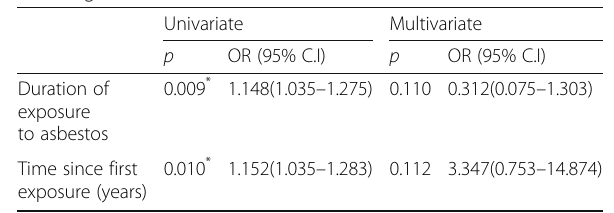
Table 3 University and multivariate analysis for the